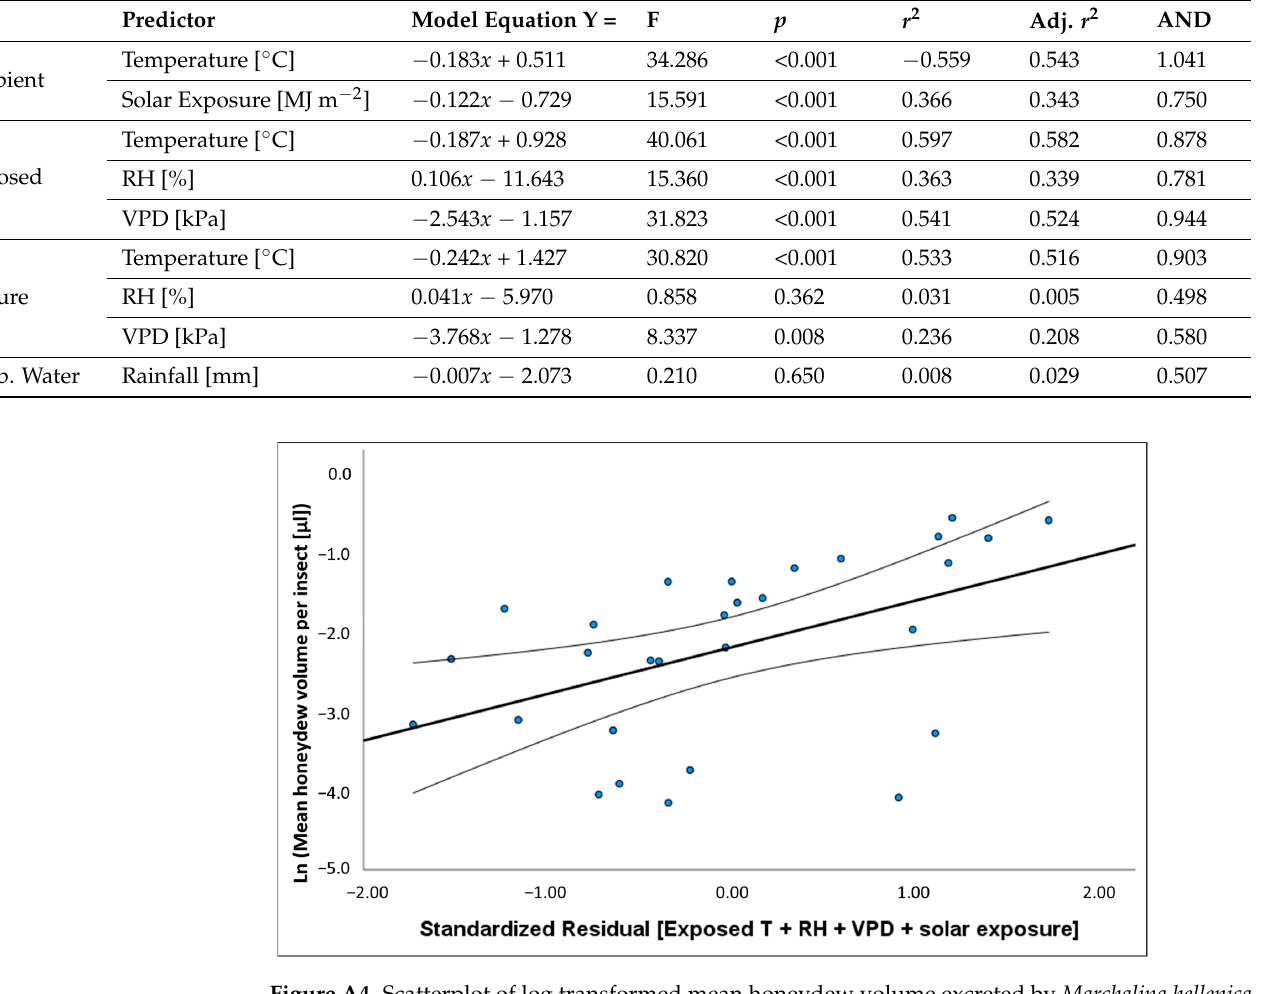
Figure A4. Scatterplot of log transformed mean honeydew volume excreted by Marchalina hellenica ( μ L) plotted over standardised residual of best climate predictor variables with exponential regression model plotted as curved black line. Curved black lines indicate 95% confidence interval of the mean. Climate variables were plotted if they provided the strongest model identified for equivalent climate variable. Summary: p = 0.008, F 1,27 = 8.196, r 2 = 0.233; model equation: Y = 0.583 × log( x ) − 2.215.